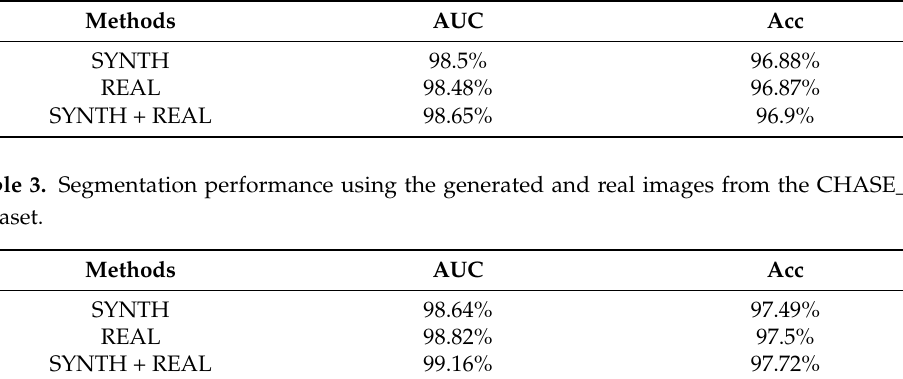
Table 2. Segmentation performance using the generated and real images from the DRIVE dataset.